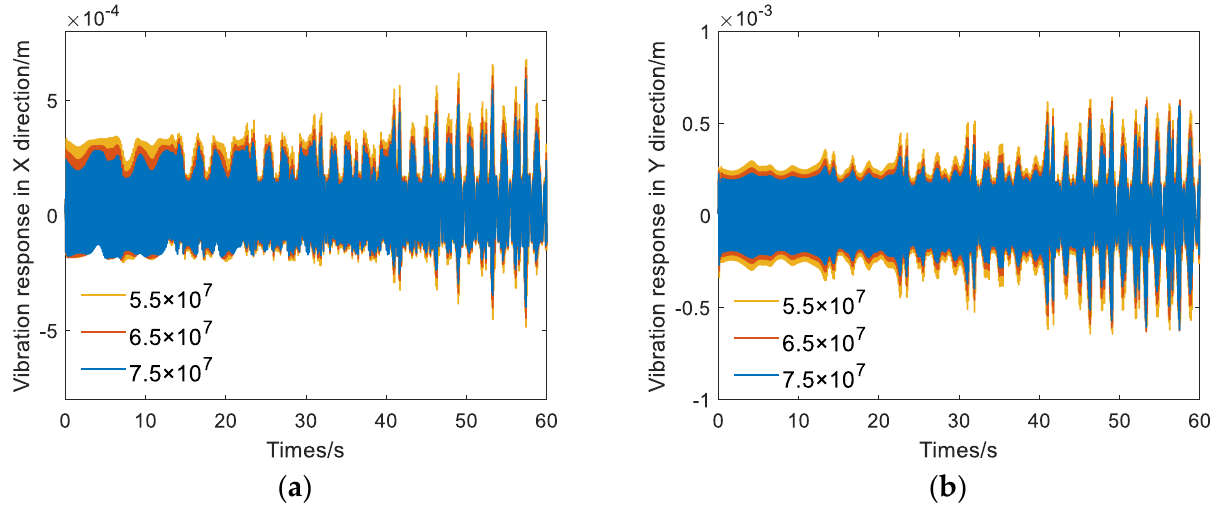
Figure 10. Shafting vibration response in the X and Y directions of the unit with different k 2 ; ( a ) shafting vibration response in X direction; ( b ) shafting vibration response in Y direction.